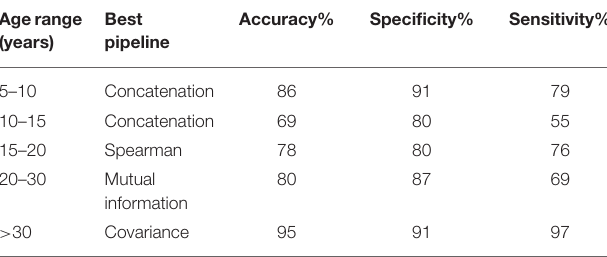
TABLE 2 | Classification performance of the best